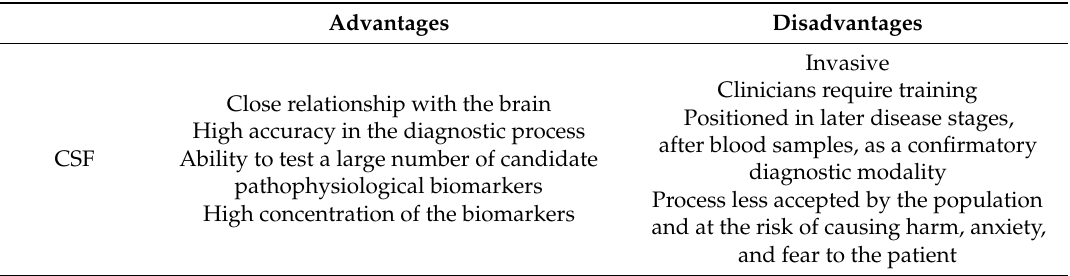
Table 1. Advantages and disadvantages for each category of biological fluids used to isolate Alzheimer’s disease